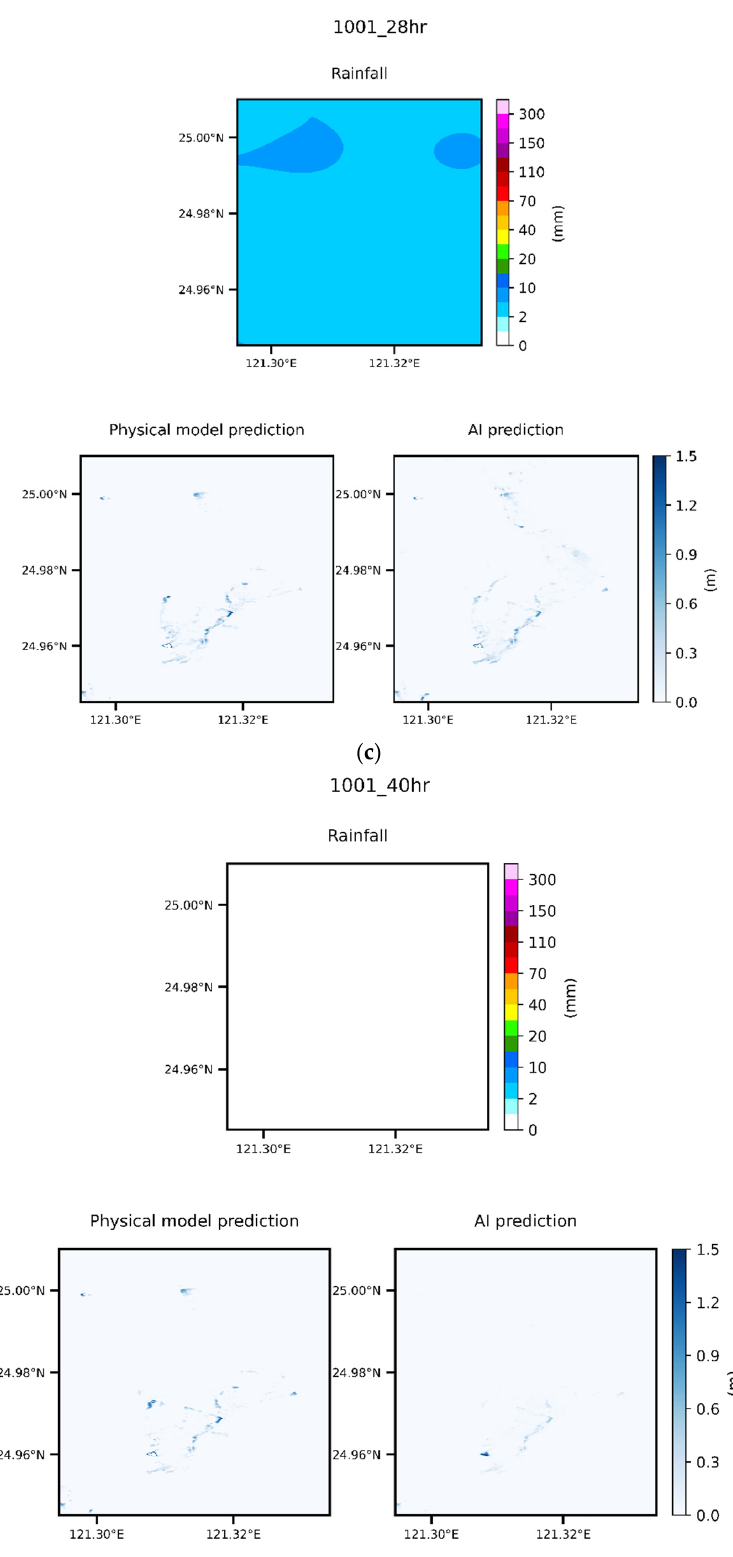
Figure 18. Two-dimensional results obtained using the Inception architecture and accumulated rainfall data containing XYZ information in comparison with the physical model results at time points of ( a ) 16; ( b ) 20; ( c ) 28; and ( d ) 40